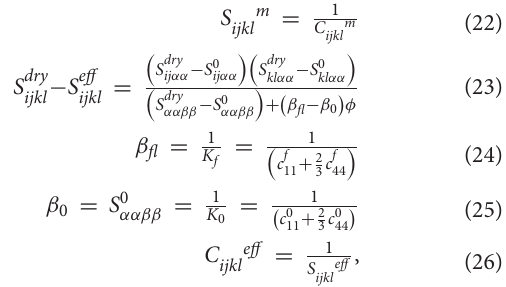
where c 0 is the isotropic background modulus obtained in the ij previous step, c 1 is the first-order fracture influence factor, and ij c 2 is the second-order fracture influence factor that reflects the ij interaction between fractures. According to the model of Hudson (1980, 1981), we obtain the